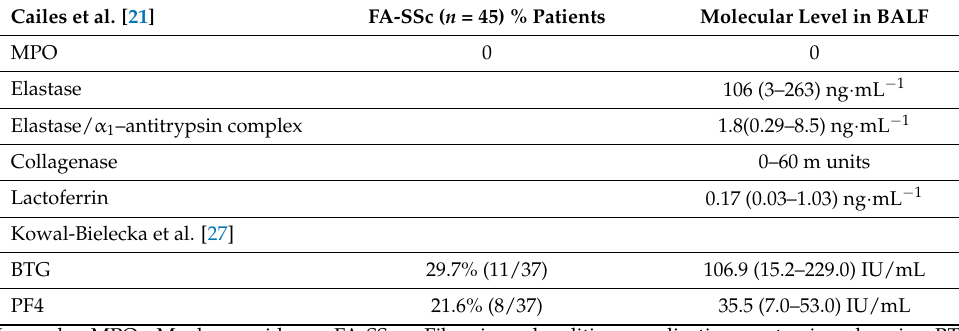
Table 3. Biomarkers values in BALF from SSc